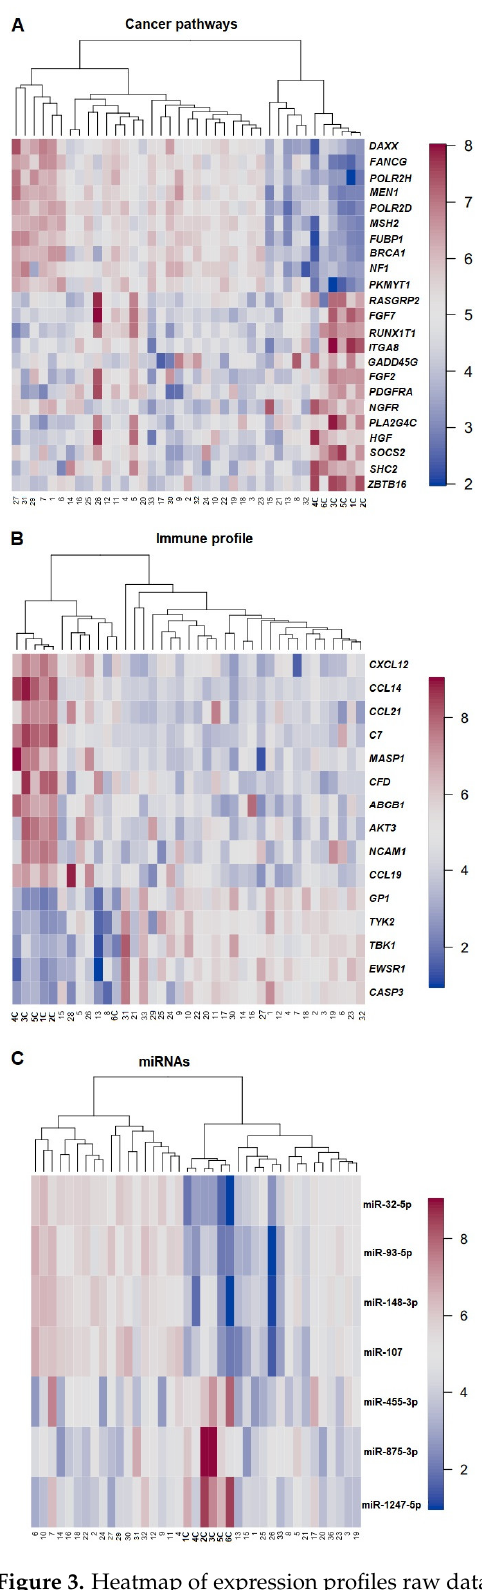
Figure 3. Heatmap of expression profiles raw data for cancer pathways ( A ), immune profile ( B ), and miRNAs ( C ). Samples are arranged in columns and the genes, and miRNAs expression levels are arranged in rows. The blue shades indicate reduced expression, and the red shades indicate increased expression. Numbers in bold highlight control